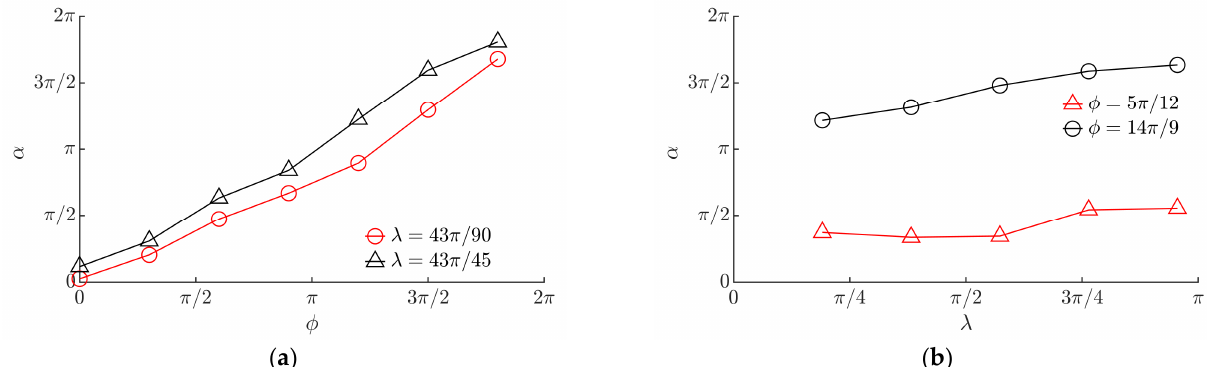
Figure 13. Experimental results of α depending on the following: ( a ) ϕ when R = 0.49 mm, ω = 62.83 rad/s; ( b ) λ when R = 0.49 mm, ω = 62.83 rad/s.